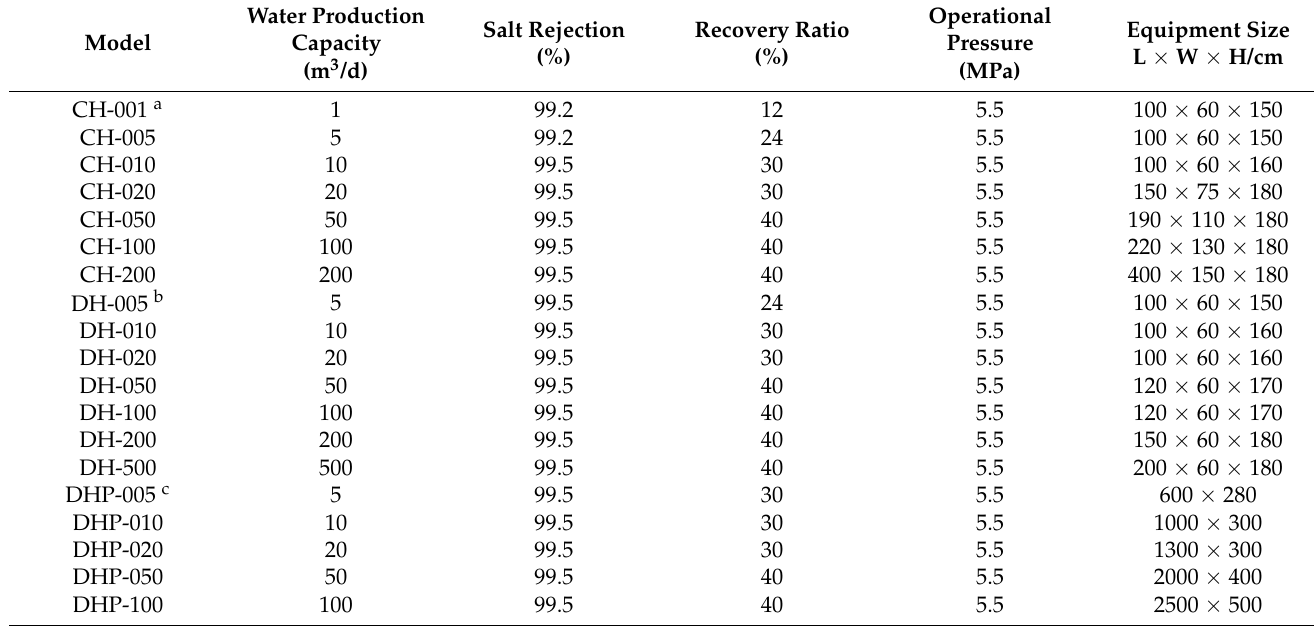
Table 2. Specifications of equipment models from